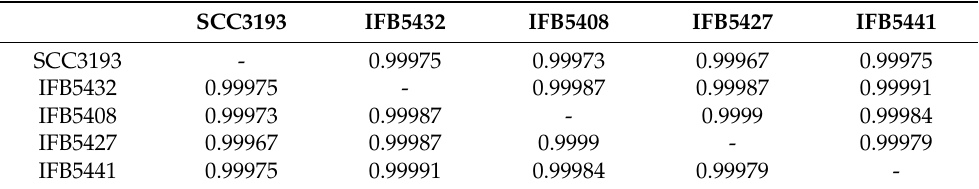
Table 4. Correlation indexes of the tetra-nucleotide signatures computed for the studied P. parmentieri